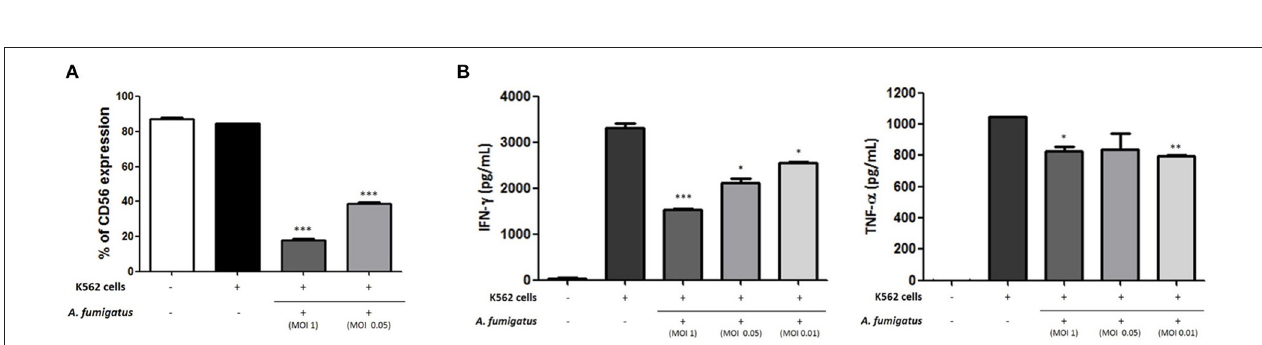
FIGURE 7 | Aspergillus fumigatus impairs NK cell cytokine responses to leukaemic cells (A) . A. fumigatus reduces NK cell surface CD56 expression during co-incubation with the K562 leukaemic cell line. NK cells were incubated with K562 cell line at an effector:target ratio of 1:1 either in absence or presence of A. fumigatus resting conidia at different MOIs. Following overnight incubation, CD56 expression was determined by FACS, gating live NK cells. Bar graph shows the mean + SEM of CD56 expression. This data is representative of three independent experiments. Statistical analysis was performed using the Student’s unpaired t -test. *** p < 0.001 (B) . A. fumigatus impairs NK cell cytokine response to K562 cell line. NK cells were incubated with K562 cell line at an effector:target ratio of 1:1 either in absence or presence of A. fumigatus resting conidia at different MOIs. Following overnight incubation, the supernatant of the co-cultures was collected and IFN- γ and TNF- α concentration was determined by ELISA. Bar graphs show the mean + SEM of IFN- γ and TNF- α production. These data are representative of three independent experiments. Statistical analysis was performed using the Student’s unpaired t -test. * p < 0.05, ** p < 0.01, *** p < 0.001.